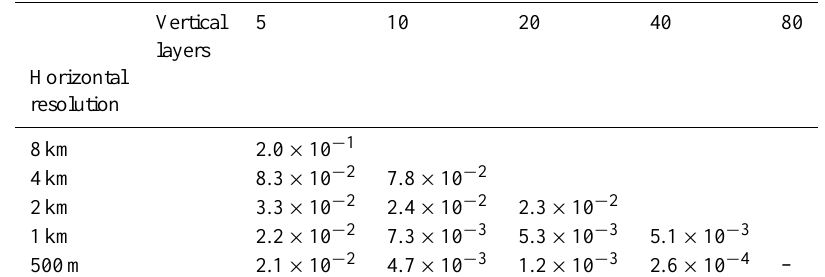
Table 5. Relative errors for the GIS mesh convergence study with graded vertical spacing.